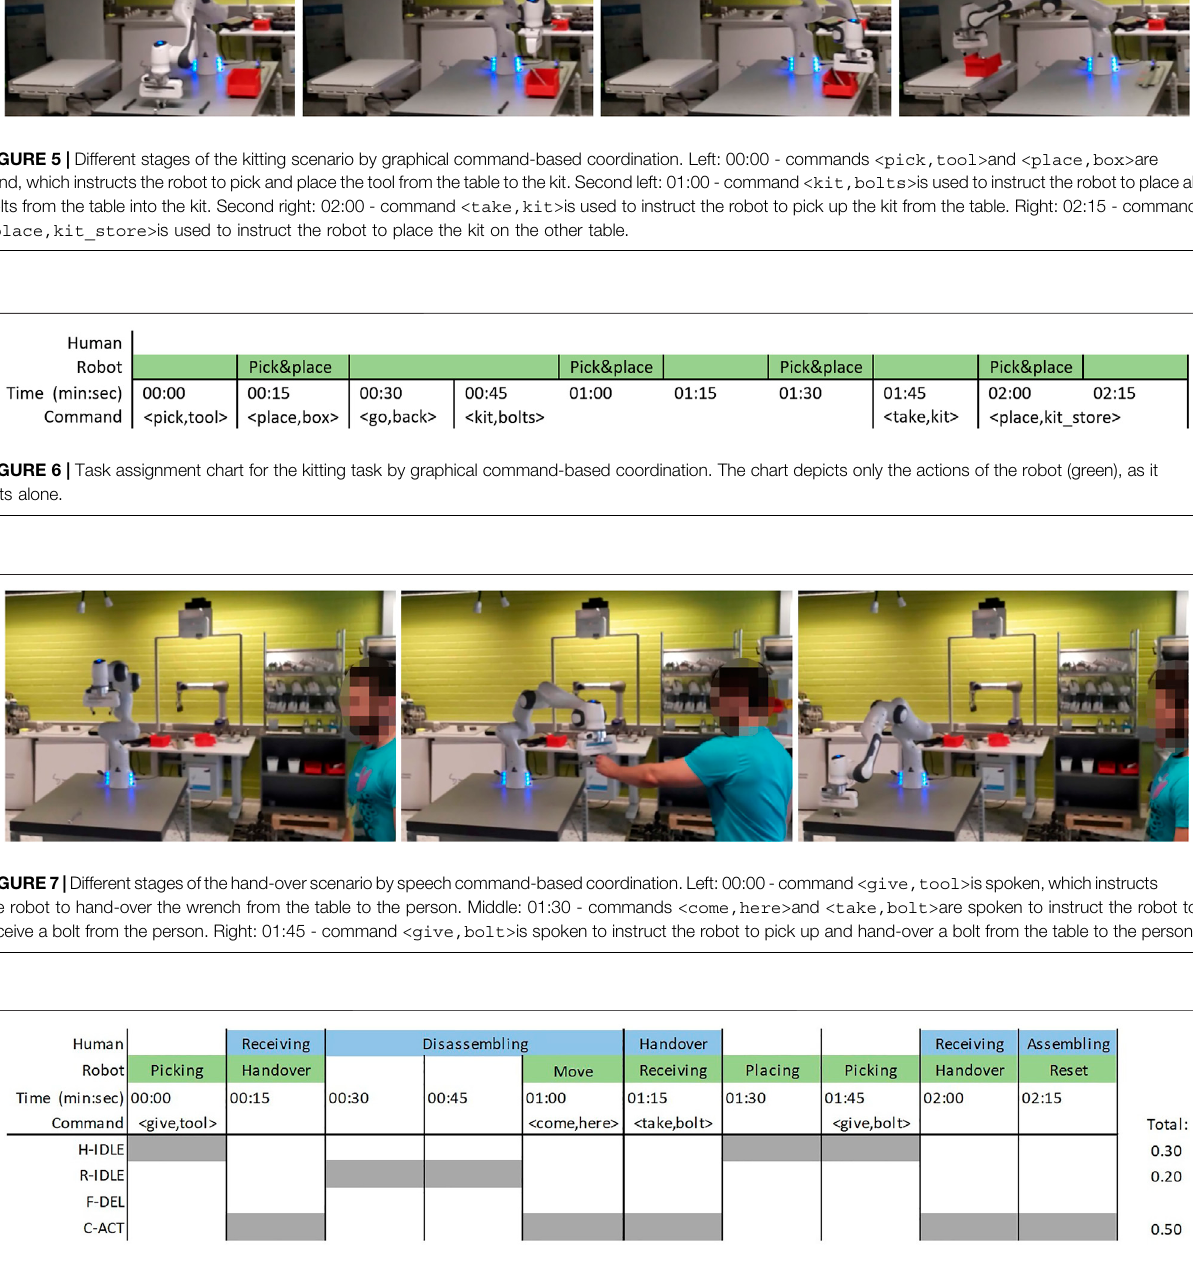
FIGURE 8 | Task assignment chart for hand-over tasks by speech command-based coordination. The chart depicts the actions of the human (blue) and the robot (green) in the shared collaborative scenario. The commands requested by the human to the robot are identical to the graphical command-based scenario. The fl uency metrics indicate a relatively low human and robot idle time (H-IDL and R-IDL) and high concurrent activity (C-ACT). Functional delay (F-DEL) is avoided completely.